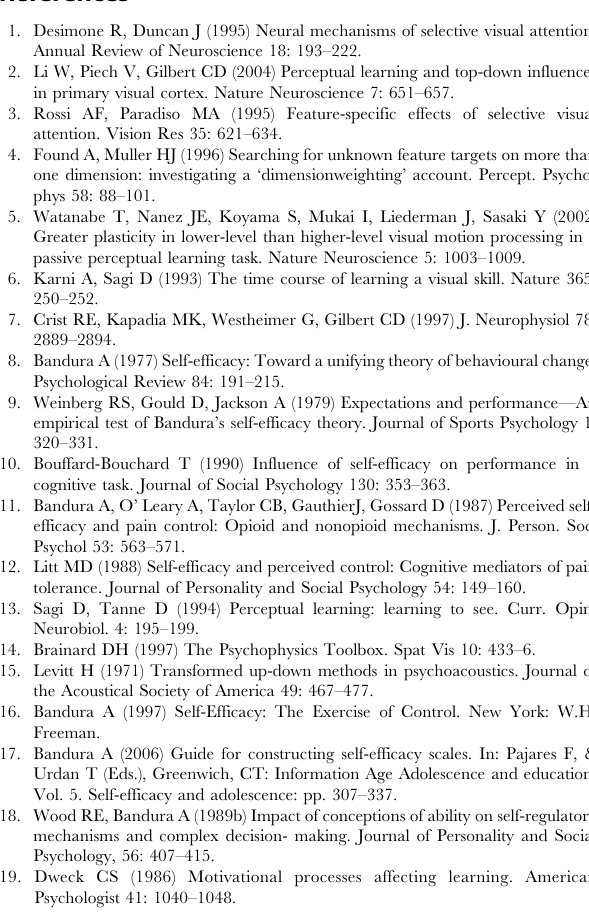
Figure S2 Orientation Self-Efficacy Questionnaire. (TIFF) Figure S3 Graphical depiction of the changes in VDS exhibited by all participants assigned to the contrast discrimination task, grouped per SE group (A: High, B: Control, C: Low). The x axis represents all the participants comprising each group while the y axis represents the change in the pop-out grating threshold. (TIFF) Figure S4 Graphical depiction of the changes in VDS exhibited by all participants assigned to the orientation discrimination task, grouped per SE group (A: High, B: Control, C: Low). The x axis represents all the participants comprising each group while the y axis represents the change in the pop-out grating threshold. (TIFF) Table S1 Sample size per each of the total 6 groups (118 participants).